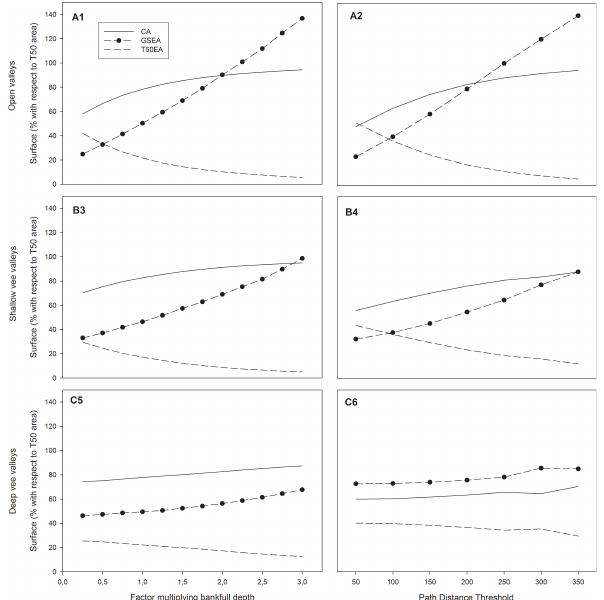
Fig. 8. Adjustment parameters when using a 30-m DEM: coinciding area (CA), 50-yr flood exceeding area (T50EA) and geomorpholog- ical surface exceeding area (GSEA) for bankfull depth ( 1 , 3 and 5 ) and path distance ( 2 , 4 and 6 ) approaches in open valleys ( A ), shal- low vee valleys ( B ) and deep vee valleys ( C